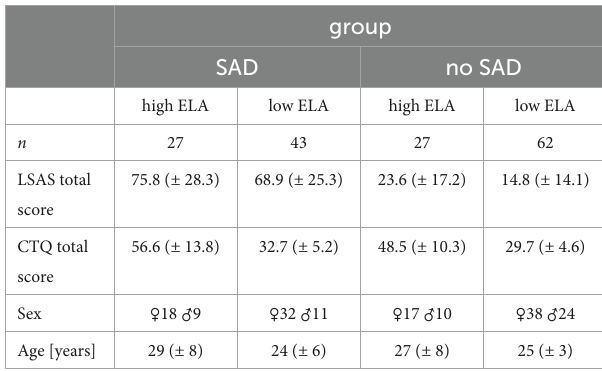
TABLE 1 Sample characteristics for the four groups emerging from the factors SAD and